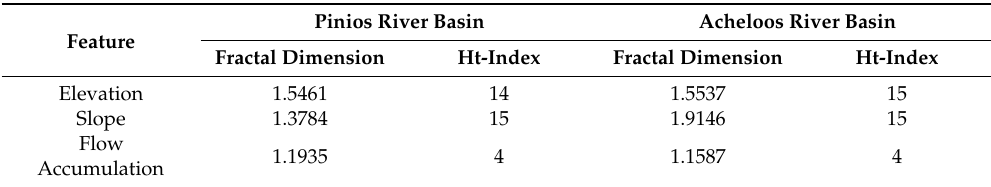
Table 9. A summary of the fractal dimension and ht-index values estimated for the studied topographic and hydrographic features in Pinios and Acheloos river